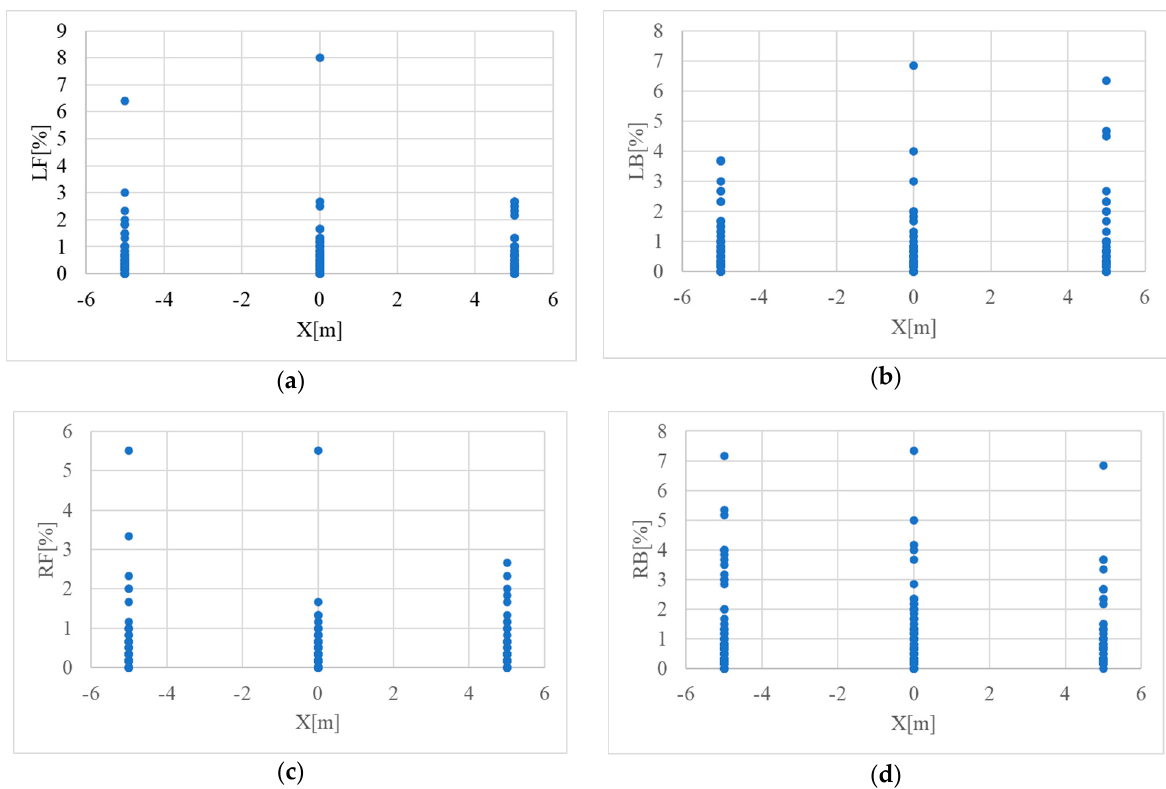
Figure 13. Relations between the number of lost data packets from Anchors: ( a ) LF, ( b ) RF, ( c ) LB, ( d ) RB, and the X tag coordinate.